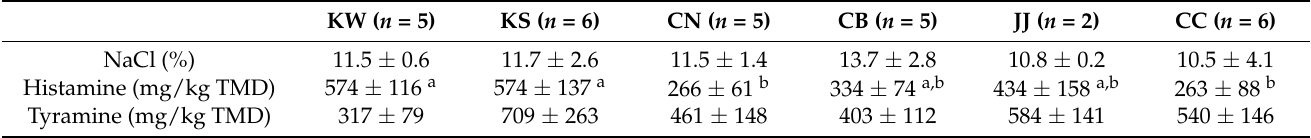
Table 1. Histamine, tyramine, and salt contents in traditionally made doenjang (TMD) samples from different areas of